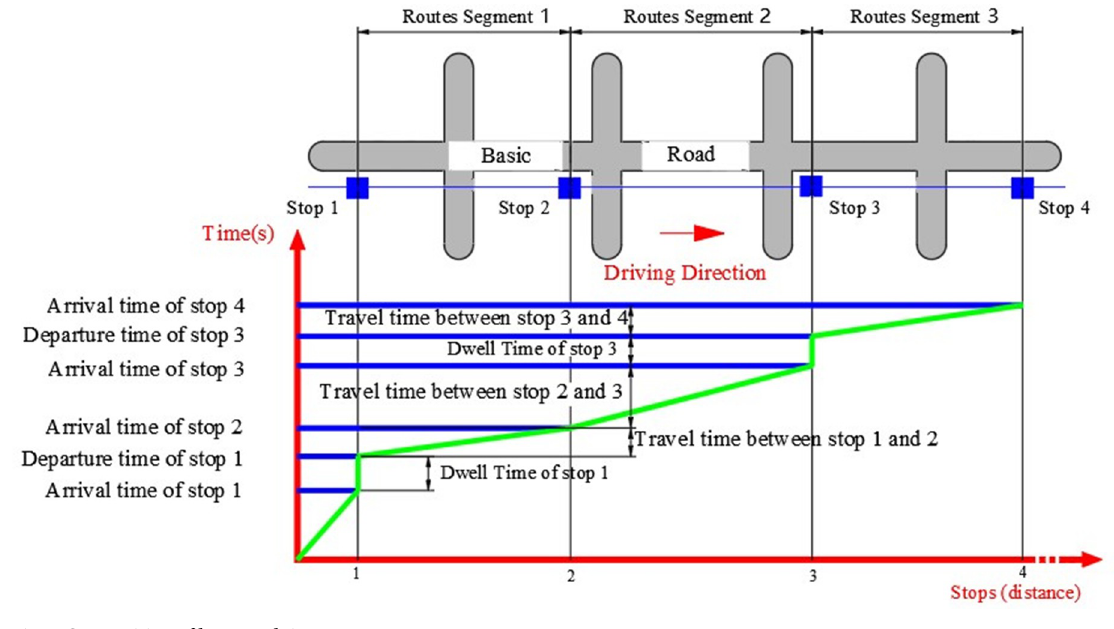
Fig 2. Composition of bus travel